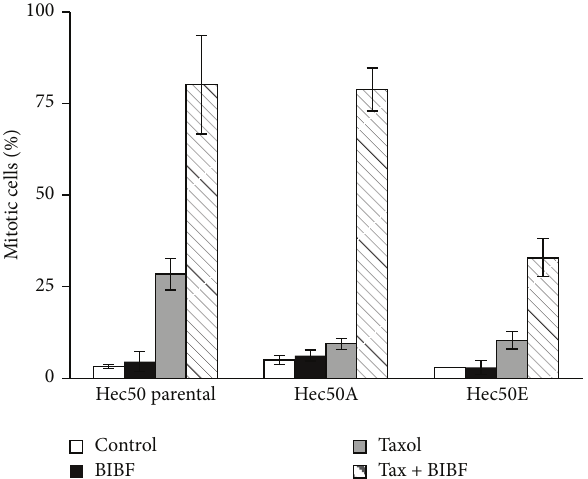
Figure 4: BIBF1120 and paclitaxel increase the percentage of mitotic parental and paclitaxel-resistant Hec50co cells. Parental Hec50 (a) or paclitaxel-resistant Hec50A (b) or Hec50E (c) endometrial cancer cells were treated with 14nM paclitaxel for 24 h with or without 1 𝜇 M BIBF1120, followed by assessment of the percentage of mitotic cells.